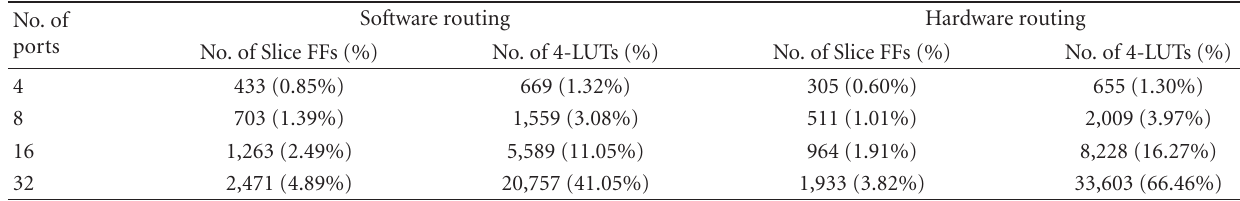
Table 1: AIREN resource utilization on V4FX60 FPGA.